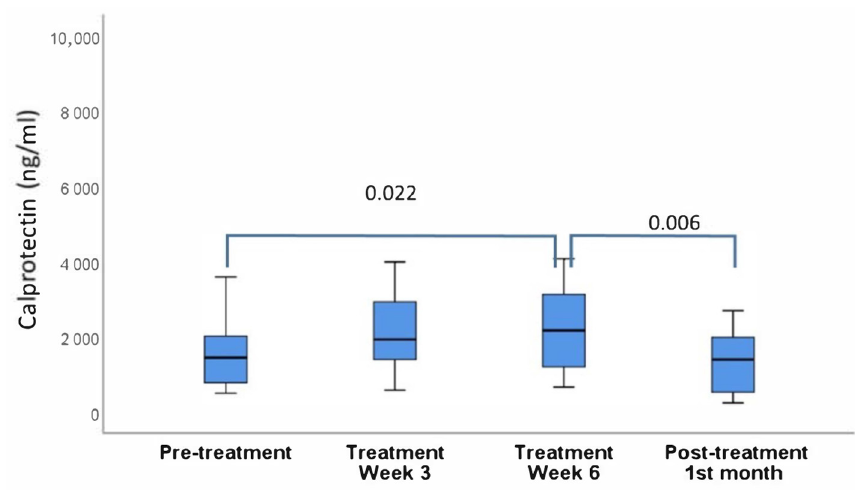
Figure 2. Oral rinse calprotectin levels before, during and after radiotherapy. Significant differences are marked with connector lines and p values.